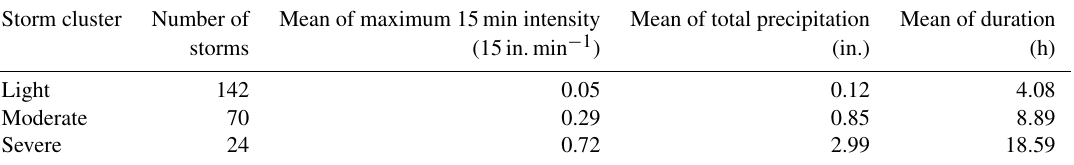
Table 3. Summary statistics of storm clusters.